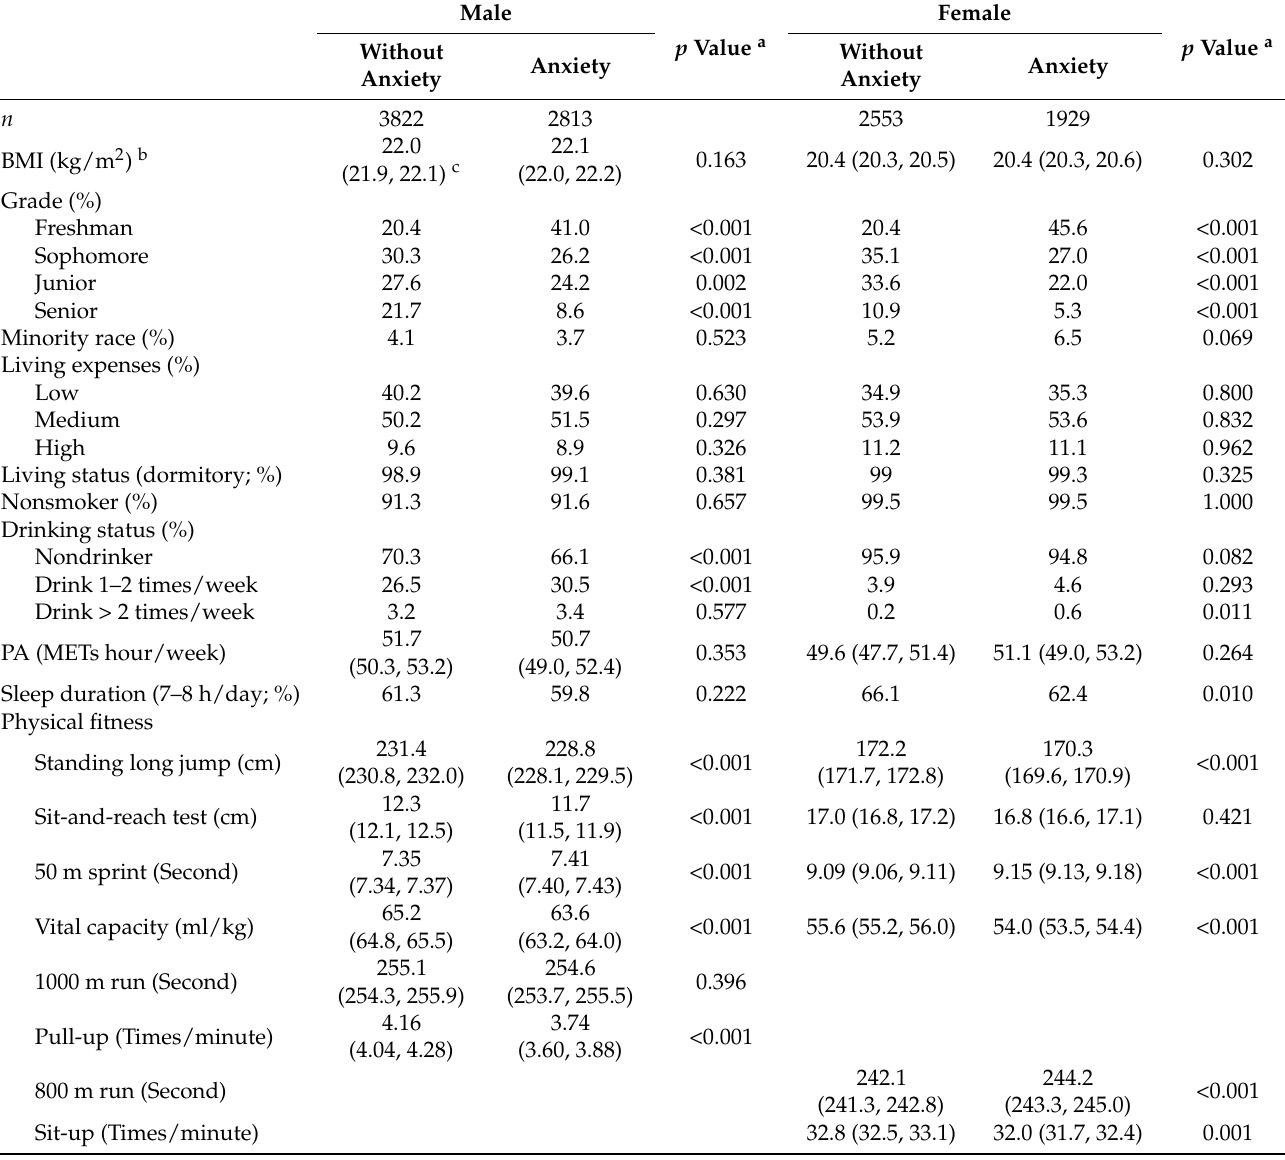
Table 1. Characteristics of male and female participants according to anxiety symptoms. Male p Value